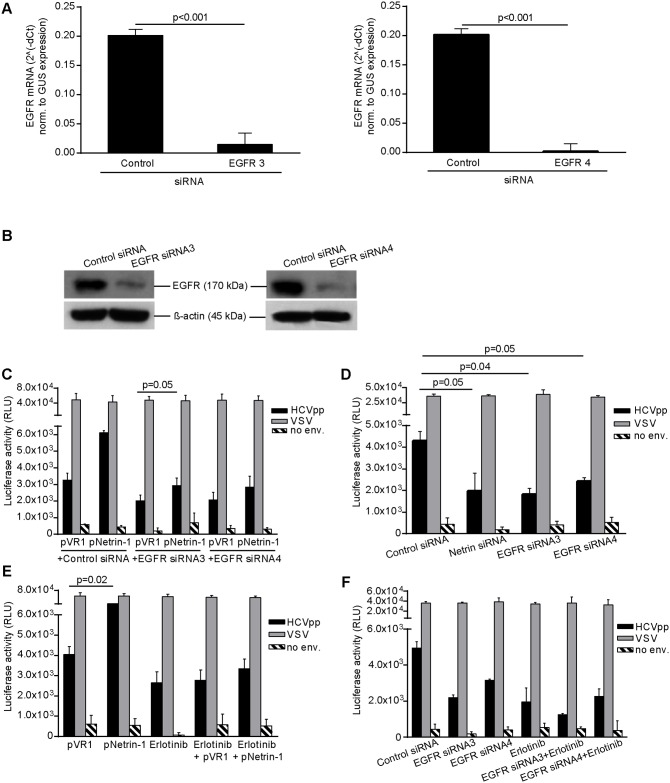
Netrin-1 enhances HCVpp entry.RNAi-mediated knockdown of EGFR. Huh7.5 cells were transfected with anti-EGFR siRNAs #3 and #4 of a previously described study [3] and infected at a MOI of 0.1. Cells were collected 3 d post-infection and analyzed by RT-qPCR (A) and immunoblotting using an anti-EGFR antibody targeting an extracellular epitope of the protein (B) (data are represented as mean ± standard deviation, n = 4, Mann-Whitney test, p < 0.05 for RT-qPCR). Parental Huh7.5 cells transfected with Netrin-1 siRNAs or plasmids or EGFR #3 or EGFR #4 siRNAs were transduced with lentiviral vectors producing HCV pseudoparticles (HCVpp), VSV-G, and envelope-negative (no env.) particles carrying a luciferase expression cassette. C. Effect of Netrin-1 overexpression on HCVpp entry and its reversion by EGFR depletion. D. Effect of Netrin-1 knockdown on HCVpp entry. E. Effect of Netrin-1 overexpression on HCVpp entry and its reversion by erlotinib. F. Effect of erlotinib treatment combined with EGFR knockdown on HCVpp entry. Cells were lysed 3 d post-infection and luciferase activity was subsequently monitored by a luminometer (data shown as mean ± standard deviation, n = 3, Mann-Whitney test, p < 0.05). The underlying data for panels in this figure can be found in S1 Data.